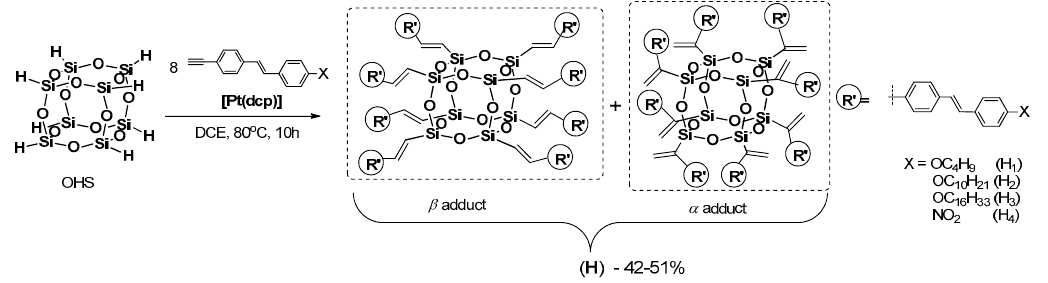
Figure 29. Synthetic pathway for the hydrosilylation of terminal alkynes with OHS.